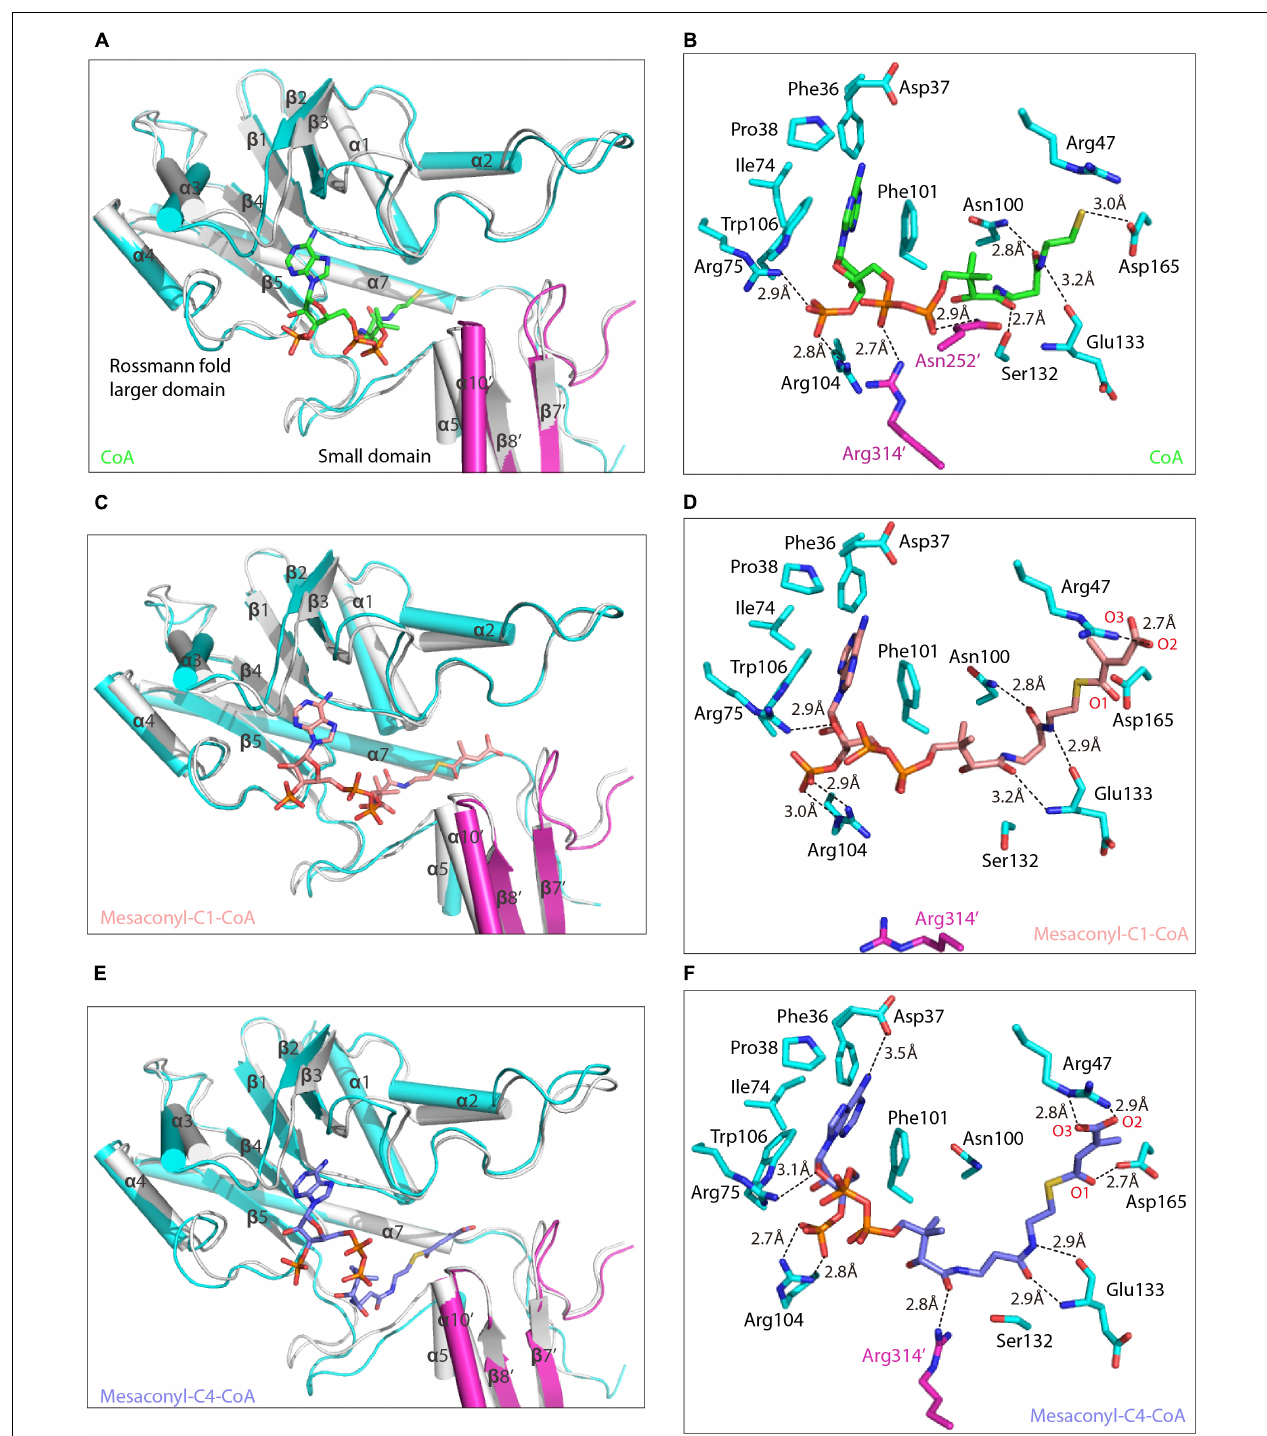
FIGURE 3 | Alternative conformations of the substrate binding pocket in binding with different CoA analogs. (A,C,E) The equilibrated binding structures of MCT in complex with CoA ( A , green), mesaconyl-C1-CoA ( C , salmon), and mesaconyl-C4-CoA ( E , blue) are superimposed with the crystal structure of apo-MCT (the two subunits of the binding structures are colored in cyan and magenta). The secondary structures that form the substrate binding pocket of MCT are shown in ribbon and labeled, and the CoA analogs are shown in stick models. (B,D,F) Coordination of three CoA analogs with the substrate binding pocket of MCT. Amino acid residues essential for coordinating the CoA ( B , green), mesaconyl-C1-CoA ( D , salmon), and mesaconyl-C4-CoA ( F , blue) are shown as stick models, the hydrogen bonding interactions are shown as dashed lines with distances labeled.